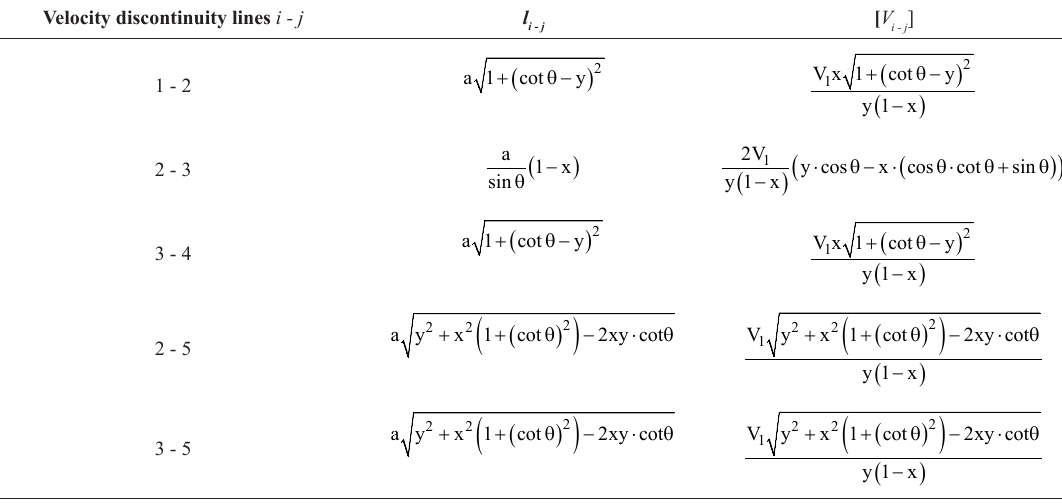
Table 1. The lines of discontinuity and sliding velocities for ECAE 2θ -die with 2θ>0° and 2θ<180° ( x=h/a and y=H/a ) in Figures 3-7. Velocity discontinuity lines i - j